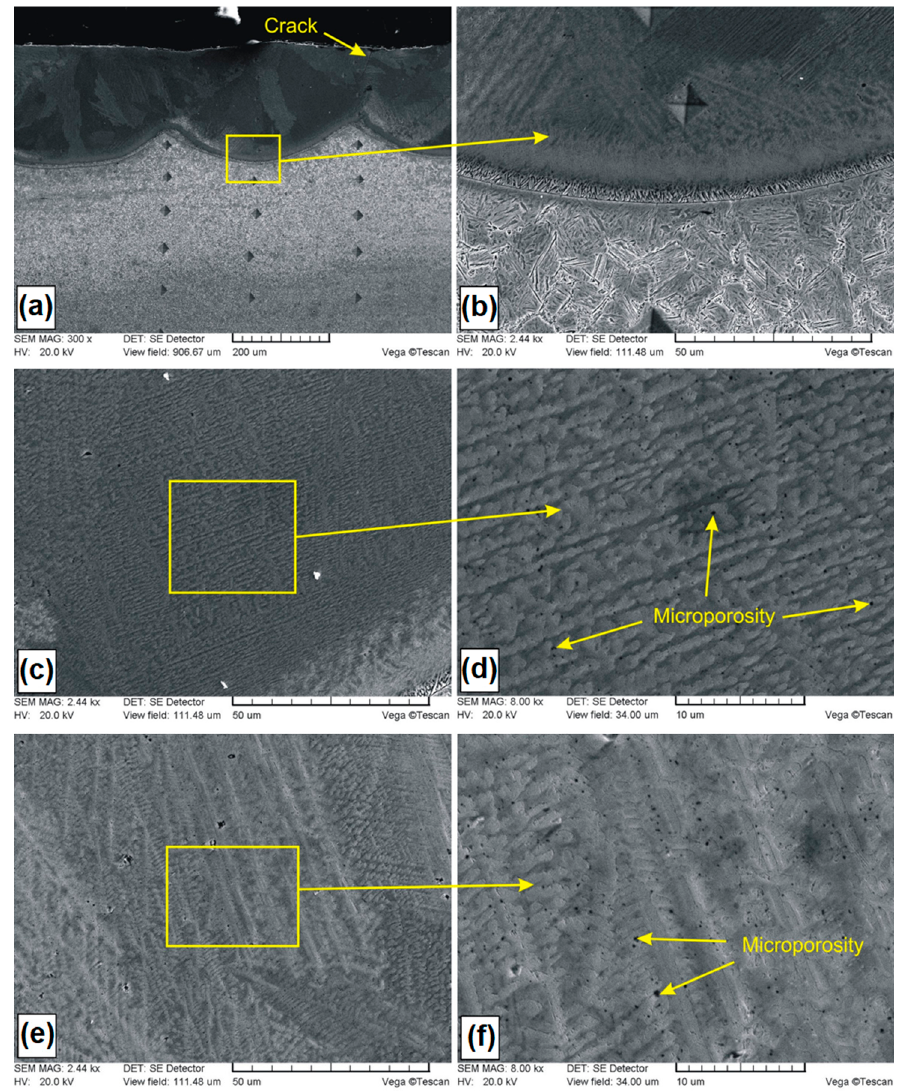
Figure 5. Microstructure of B-Si coating containing 50% boron and 50% silicon in pre-coat: ( a ) general view of laser tracks; ( b ) boundary between the MZ and HAZ; ( c ) dark area of the MZ; ( d ) magnification of dark area; ( e ) light area of the MZ; ( f ) magnification of light area.